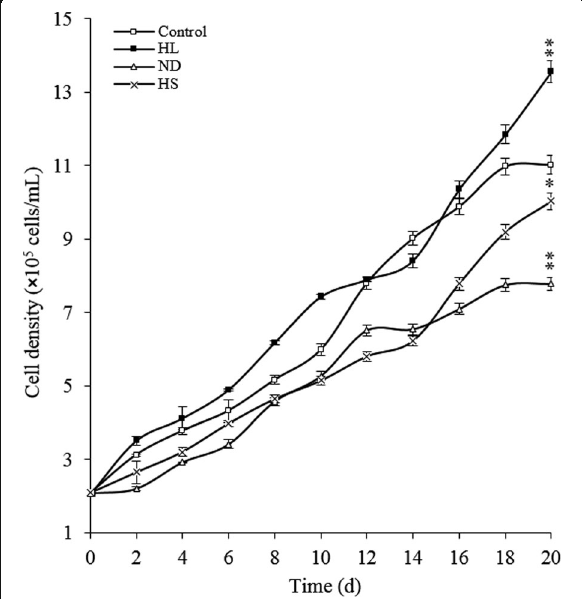
Fig. 1 Culture growth of D. salina Y6 under the tested abiotic-stress conditions. HL, high-light conditions; ND, nitrogen-depleted conditions; HS, high-salt conditions. ** p < 0.01, * p < 0.05. The values represent mean ± S.D. ( n = 3)